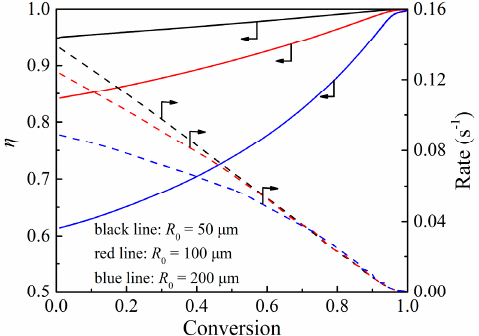
Figure 13. Calculated results of effectiveness factor and reaction rate against particle conversion under different particle sizes at 800 °C.